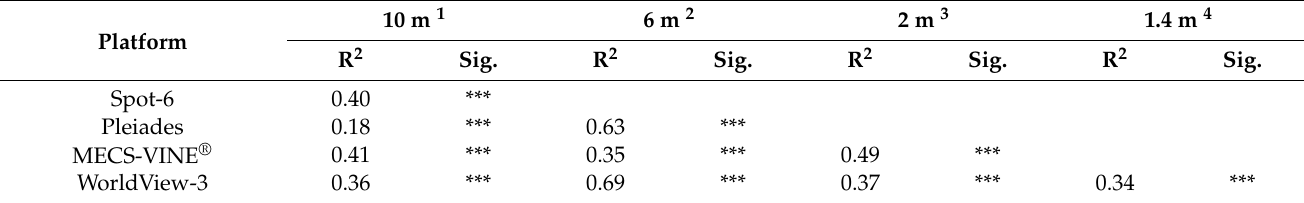
Table 3. Coefficients of determination (R 2 ) of quantitative comparison between different platforms using OLS. The images were resampled as follows: Spot-6, 10 m ground resolution; Pleiades, 6 m and 10 m ground resolution; MECS-VINE ® , 2 m, 6 m and 10 m ground resolution; WorldView-3, 1.4 m, 2 m, 6 m and 10 m ground resolution. Comparisons were performed by considering as the independent variable the vigor index value (NDVI or CI) derived from the native resolution acquisition (10 m: Sentinel-2; 6 m: Spot-6; 2 m: Pleiades; 1.4 m: MECS-VINE ® ), while the values of the resampled images were assumed as the dependent